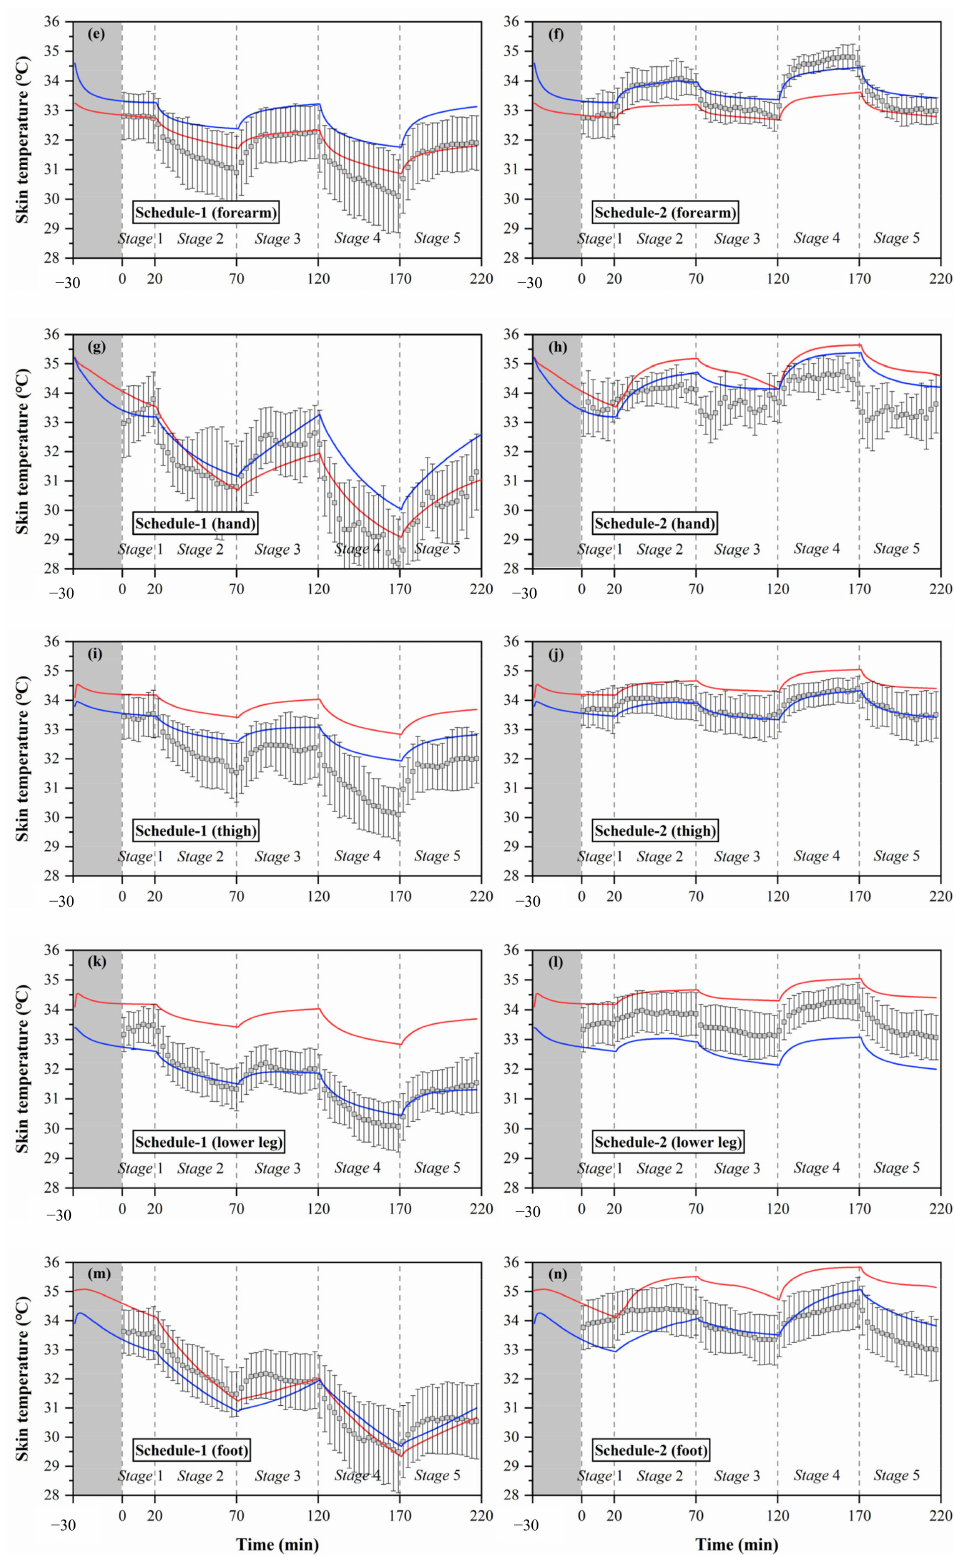
Figure 5. Local skin temperatures measured by experiments and calculated by the Stolwijk model and Tanabe model, ( a ) head temperature in schedule 1, ( b ) head temperature in schedule 2, ( c ) chest temperature in schedule 1, ( d ) chest temperature in schedule 2, ( e ) forearm temperature in schedule 1, ( f ) forearm temperature in schedule 2, ( g ) hand temperature in schedule 1, ( h ) hand temperature in schedule 2, ( i ) thigh temperature in schedule 1, ( j ) thigh temperature in schedule 2, ( k ) lower leg temperature in schedule 1, ( l ) lower leg temperature in schedule 2, ( m ) foot temperature in schedule 1, ( n ) foot temperature in schedule